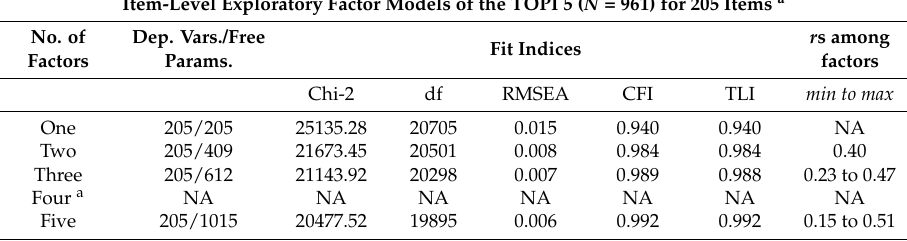
Table 2. The Exploratory Factor Analyses at the item level for Studies 1 and